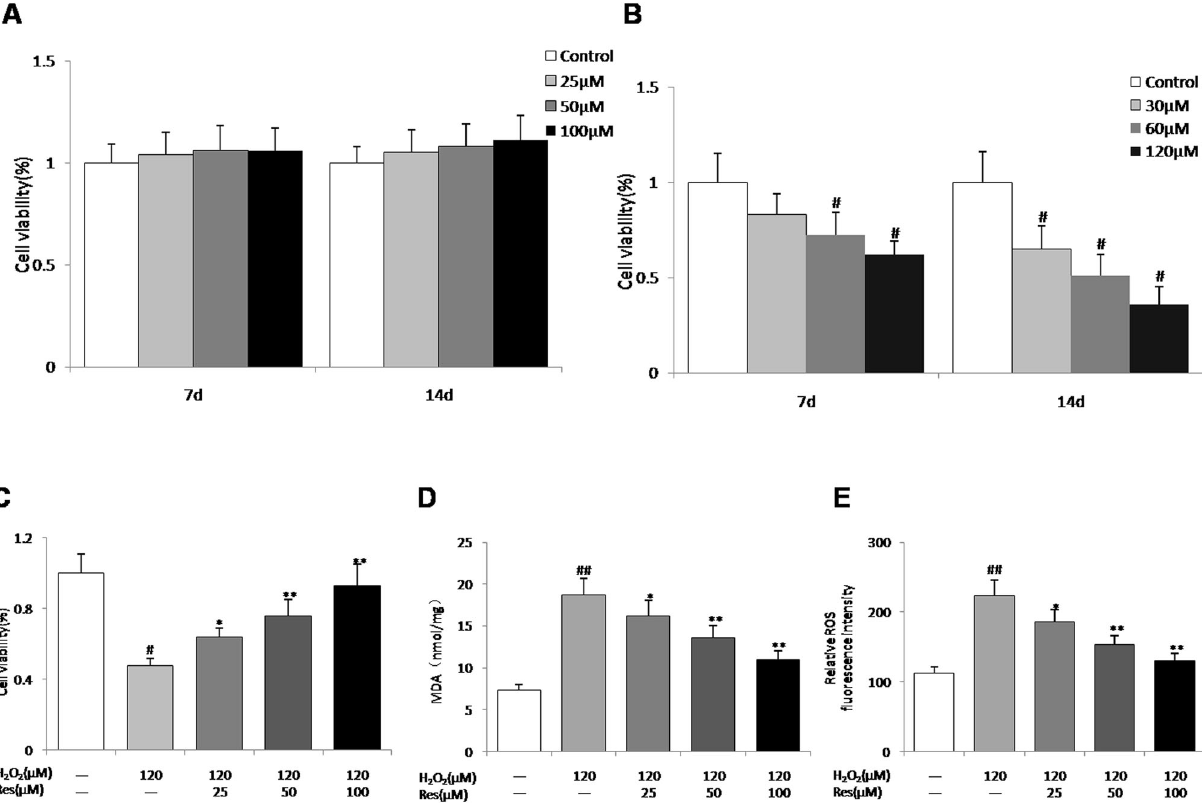
Fig. 1 Ef fi cacy of resveratrol on the viability of MLO-Y4 cells and oxidative stress. A Cell viability of MLO-Y4 cells following treatment with different concentrations of resveratrol from 7 d to 14 d. B Cell viability of MLO-Y4 cells in different concentrations of H 2 O 2 from 7 d to 14 d. C Cell viability of MLO-Y4 cells administered with resveratrol for 24 h before 120 μ M H 2 O 2 administration for 14 d. D , E Effects of different concentrations of resveratrol on MDA and intracellular ROS content in MLO-Y4 cells supernatants after treatment with 120 μ M H 2 O 2 . n = 6, P < 0.01 vs H # P < 0.05 vs control, ## P < 0.01 vs control, * P < 0.05 vs H 2 O 2 , ** 2 O 2